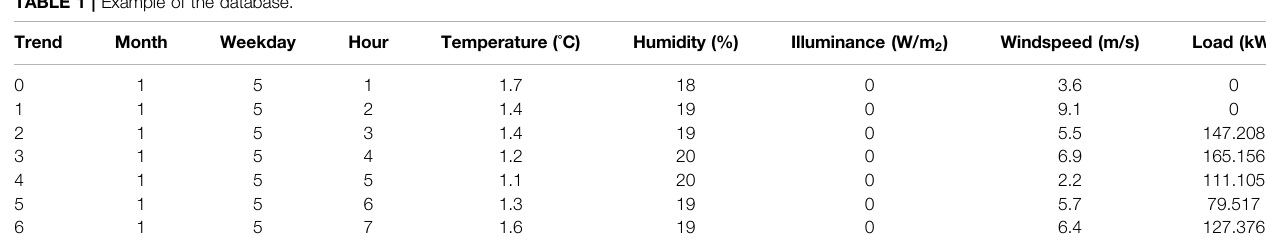
TABLE 1 | Example of the